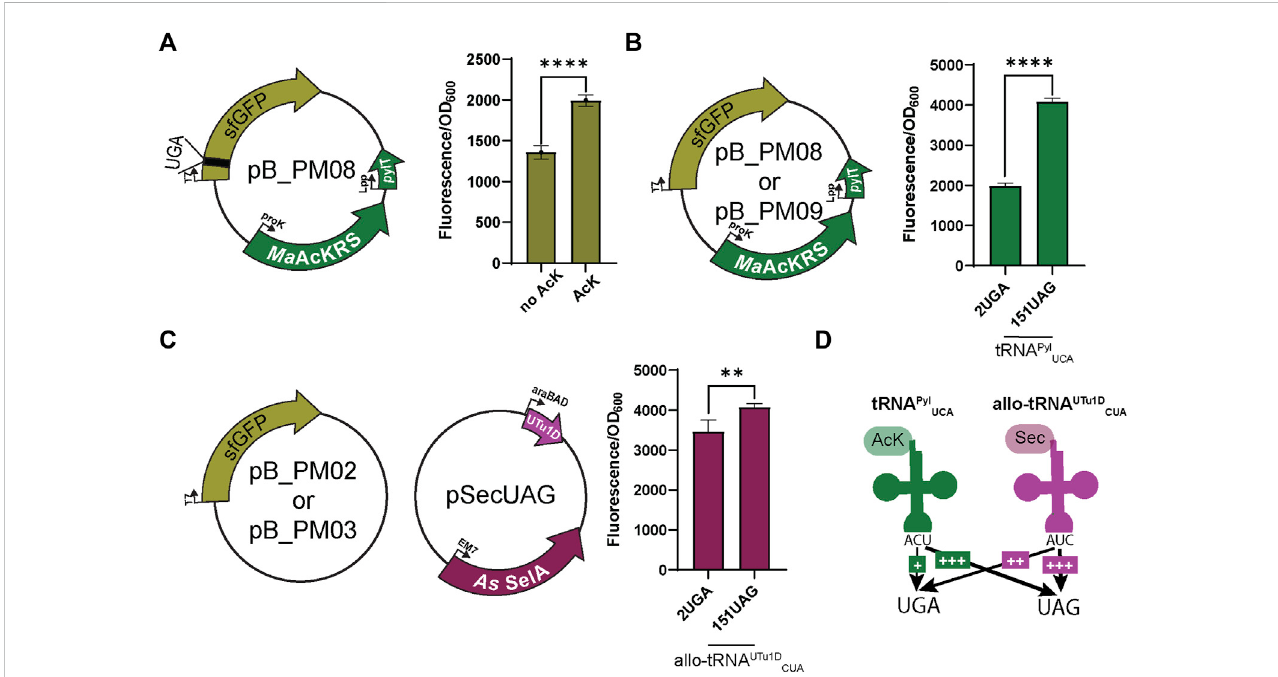
FIGURE 2 FluorescenceassayobservesbiasforUAGsuppression. (A) To fi rsttestthespeci fi cityofthe Ma AcKRSsystemforthepresenceof N ε -acetyl- L -lysine(AcK), pB_PM06 was used. This plasmid contains sfGFP under the control of a T7 promoter encoding a UGA at position 2 (2UGA), Ma AcKRS3-IP under a proK promoter, and tRNA Pyl UCA ( pylT ) under an Lpp promoter. The presence of AcK promoted sfGFP fl uorescence ( p < 0.0001, n = 4). (B) pB_PM06 and pB_ PM07 plasmids encoding 2UGA or 151UAG, respectively, were tested for the speci fi city of tRNA Pyl UCA for its cognate codon (UGA). Signi fi cant increase in readthrough fl uorescence ( p < 0.0001, n = 4) was observed for 151UAG, the non-cognate codon. (C) Combining plasmids pB_PM02 or pB_PM03 encoding 2UGA or 151UAG, respectively, and pSecUAG allowed a test for UAG suppression by allo-tRNA UTu1D CUA . This plasmid contains the machinery for insertion of Sec, namely allo-tRNA UTu1D CUA (UTu1D) under the araBAD promoter and A. salmonicida ( As ) SelA under EM7. Similar readthrough fl uorescence was observed for both codons with a preference for its cognate codon, UAG ( p < 0.01, n = 4). (D) Combining this information, tRNA Pyl UCA (green) poorly suppresses its cognate codon UGA but is much better at suppressing UAG, while allo-tRNA UTu1D CUA (magenta) also suppresses both codons with a bias towards UAG. Increase in suppression ef fi ciency is denoted by an increase in + and bolder